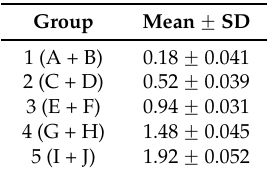
Figure 11. Experimental results for group sensing points with different weight ratios (mean value of risk level). risk level). Table 2. Statistical analysis results of risk level in the different weight ratios. Table 2. Statistical analysis results of risk level in the different weight